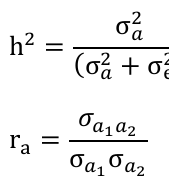
Figure 1. Breast meat weight (BMW) vs breast meat volume (BMV) and the regression line from BMV to BMW. r 2 = 0.771.